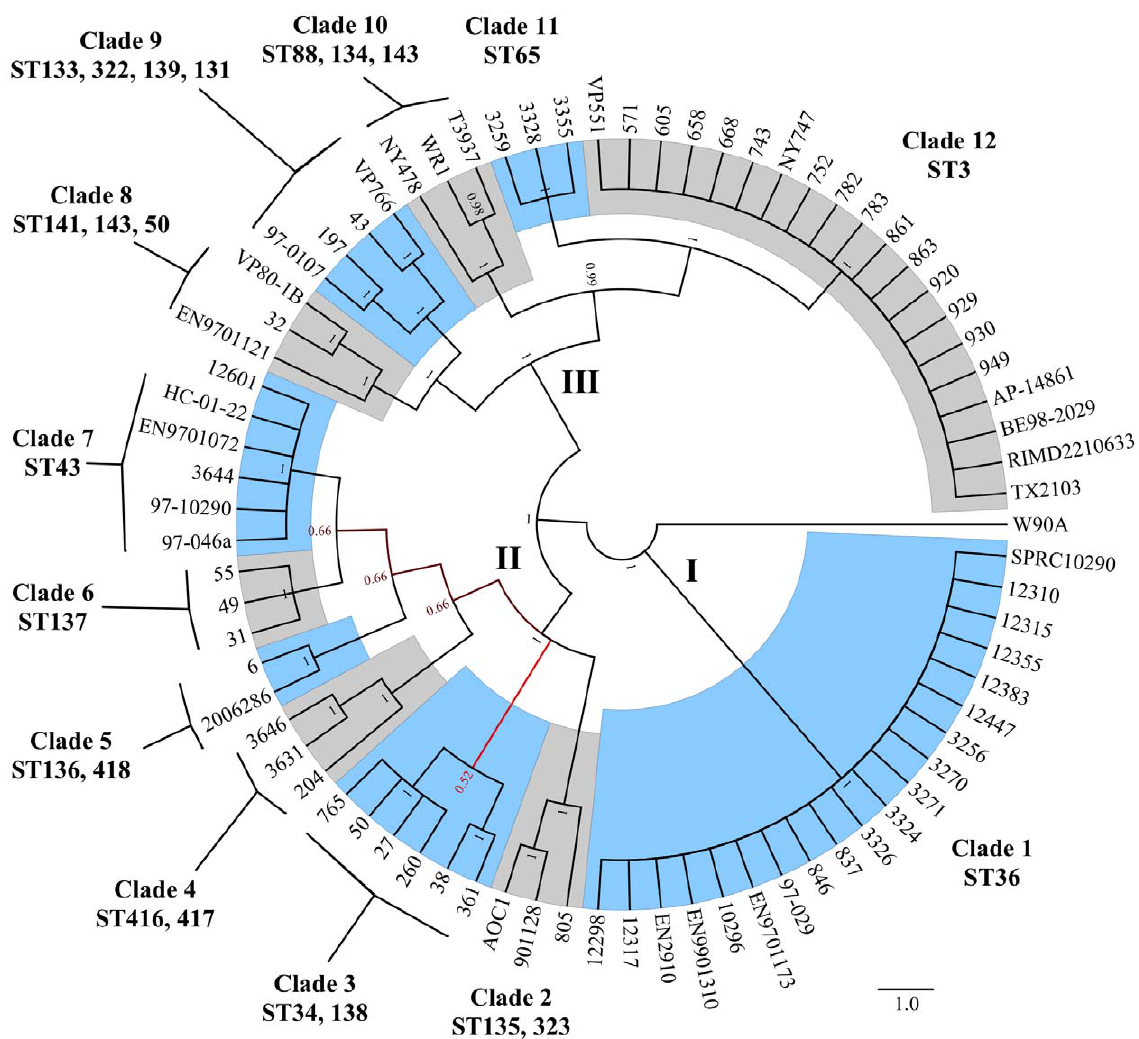
Figure 2. MLST majority consensus phylogeny. A majority consensus phylogeny of 77 V. parahaemolyticus isolates based on 7 concatenated housekeeping loci ( dna E, gyr B, rec A, dtd S, pnt A, pry C and tna A) and representing 3,682 total nucleotides was constructed using the Bayesian Markov chain Monte Carlo (MCMC) method as implemented in MrBayes v3.2. The 77 isolates included in this phylogeny were separated into three major clusters (I, II, III) and 12 distinct clades (1–12). Sequence typing (ST) designations for MLST analysis describe the 24 MLST sequence types comprising each of the 12 clades. Distinct clades clearly highlighted by alternating blue and gray shading. Nodes are labeled with posterior probabilities (0–1) while cladogram shading is indicative of branches with weak support (red) and strong support